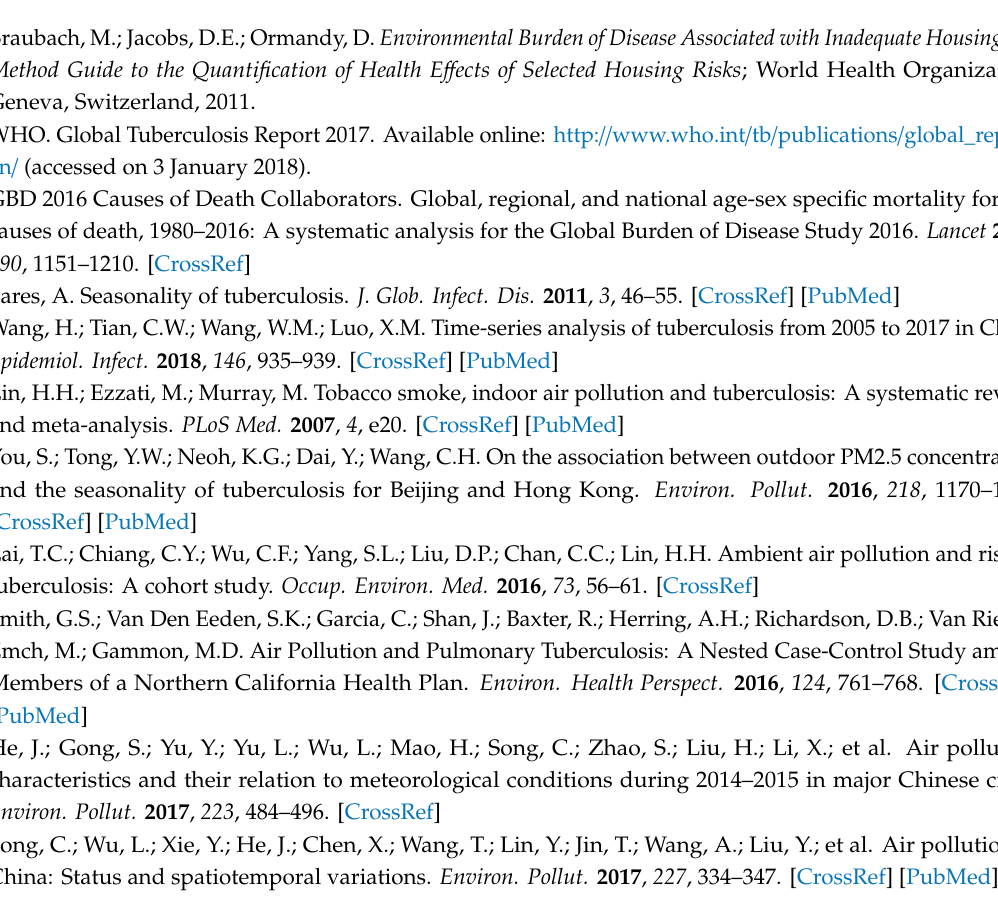
Figure S1: title, Table S1: title, Video S1: title. Figure S1: Seasonal and long-term patterns of outcome (TB cases) and exposure (PM 2.5 , PM 10 , O 3 , SO 2 , NO 2 , CO, AQI) data over time. Gray circle: raw data, solid black line: flexible cubic spline model. Figure S2: The non-linear relationships between 6-month moving average concentrations of PM 2.5 , PM 10 , SO 2 and AQI, as well as 7-month moving average concentrations of NO 2 , CO and O 3 and risk of tuberculosis. The solid lines indicate the estimated log relative risk of tuberculosis and the dashed lines indicate the corresponding 95 % confidence